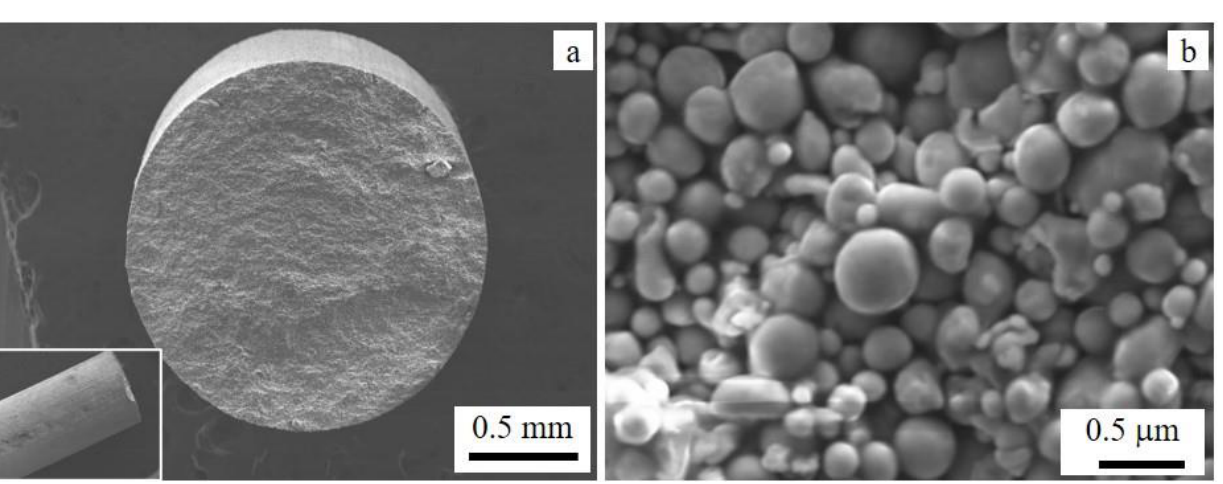
and ( b ) high-resolution image showing components of the filament. The inset in ( a ) is the axial view